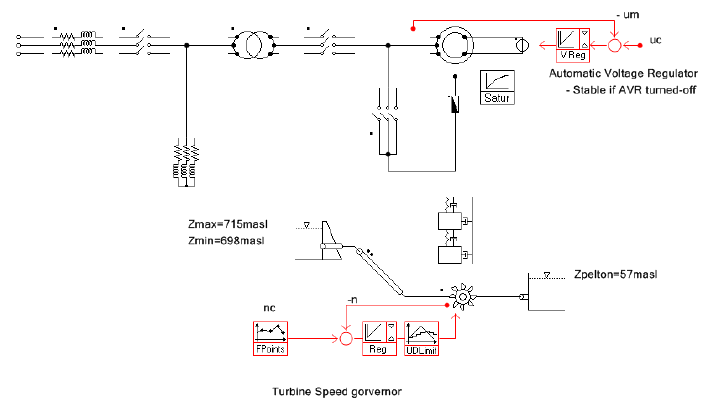
Figure 7. El Hierro combined wind and pumped-storage hydro power plant simplified simulation model, as implemented in SIMSEN software (EPFL, Ecublens, Lausanne, Switzerland) for wind-generator trip simulation. Pelton turbine driven generator.